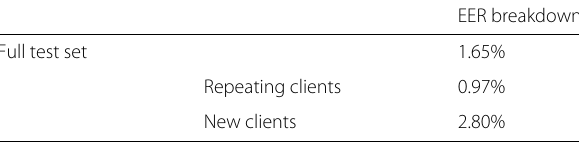
Table 3 Results for the XM2VTS test set and open-set